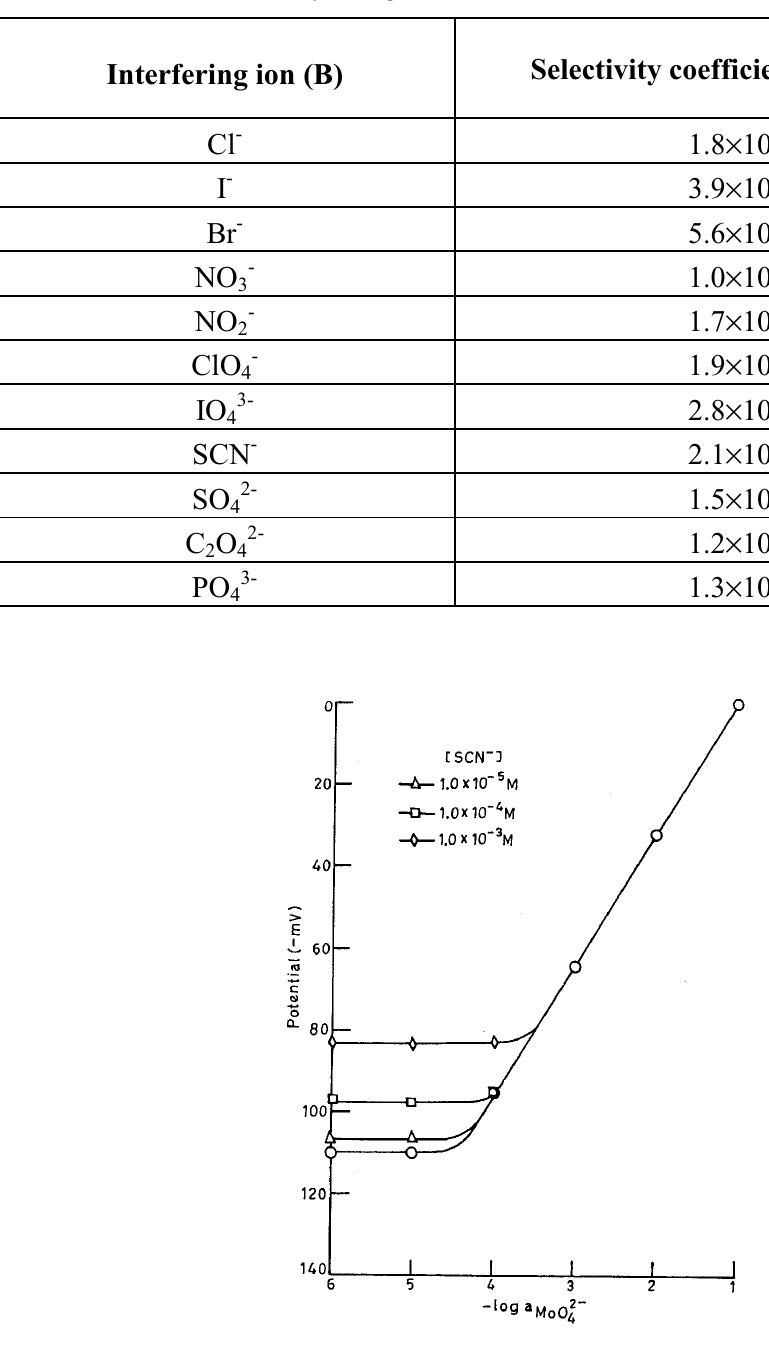
Pot K observed for MoO 42- selective − 2 B,MoO 4